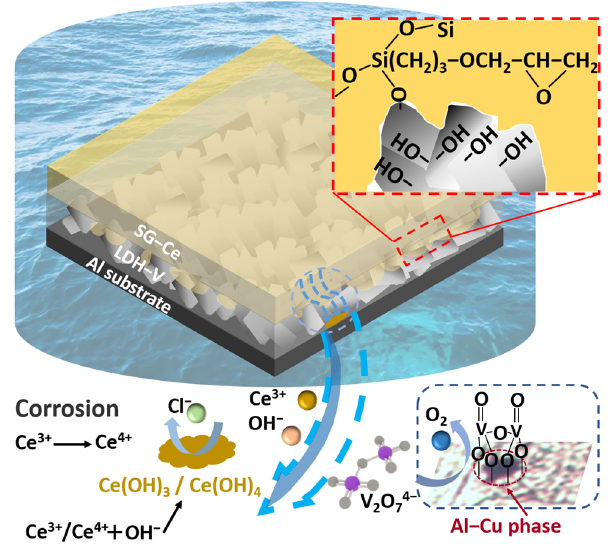
Figure 7. Schematic representation of coating formation mechanism of LDH/SG composite film.